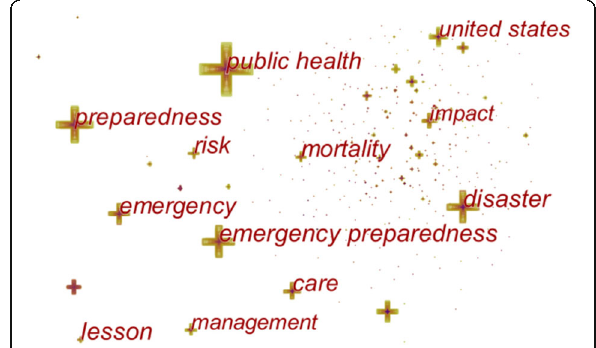
Fig. 7 Keywords co-occurrence network of international database. The colors of crosses of a circle are corresponding to the year. The size of nodes represent research frequency of the